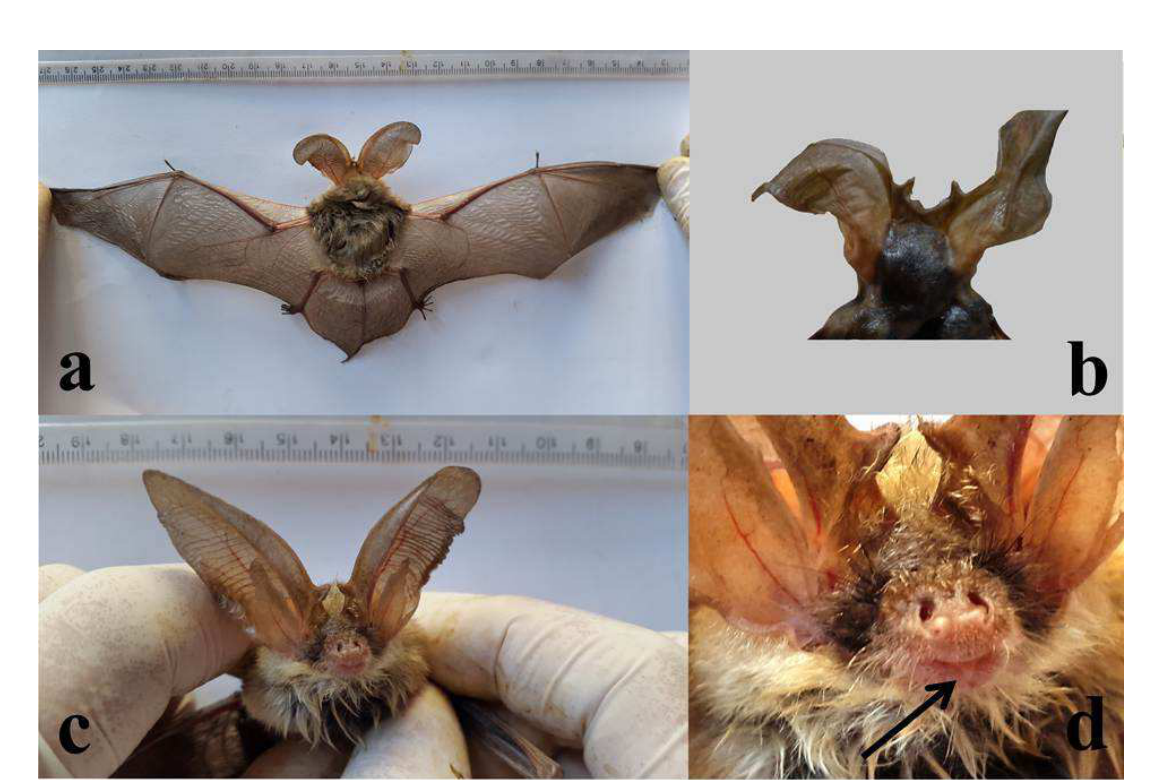
F IGURE 3 . Photos of the Plecotus macrobularis Kuzjakin, 1965. a) dorsal view; b) ears connection in front at their bases; c) ventral view of head; d) triangle pad on the lower lip as a diagnostic